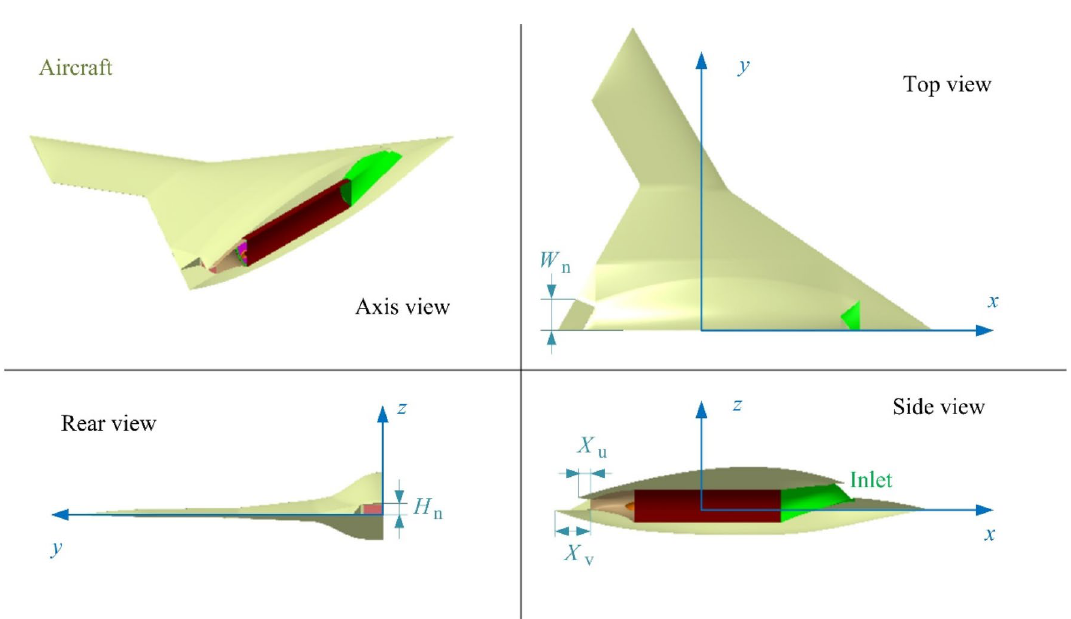
Figure 5. Aircraft design draft and parameter variables, drawn using Microsoft Visio 2007.